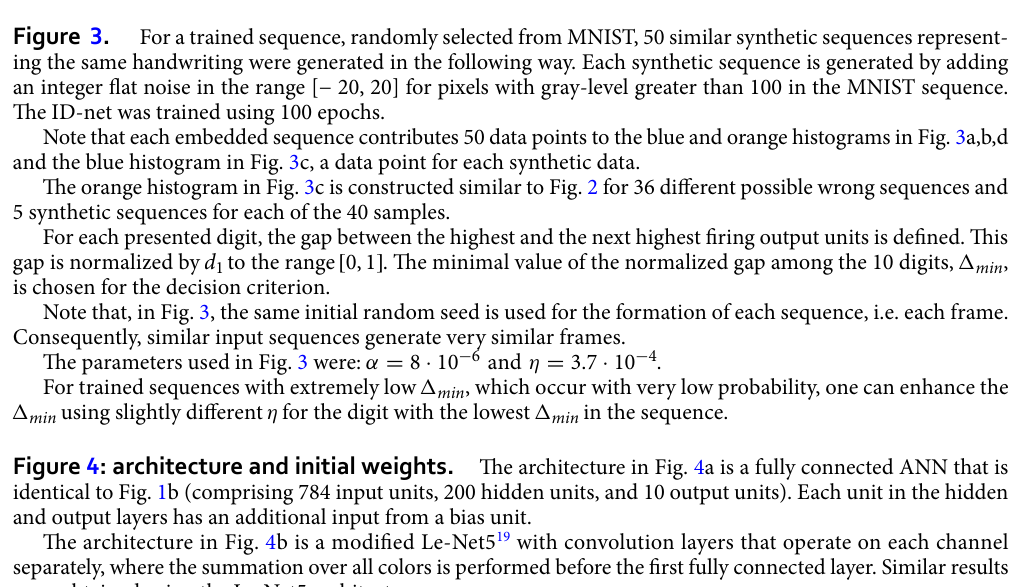
Figure 4: architecture and initial weights. The architecture in Fig. 4a is a fully connected ANN that is identical to Fig. 1b (comprising 784 input units, 200 hidden units, and 10 output units). Each unit in the hidden and output layers has an additional input from a bias unit. The architecture in Fig. 4b is a modified Le-Net5 19 with convolution layers that operate on each channel separately, where the summation over all colors is performed before the first fully connected layer. Similar results were obtained using the Le-Net5 architecture. The initial conditions of all weights are randomly chosen from a Gaussian distribution with a zero mean and standard deviation of one. Input: Each example of the MNIST